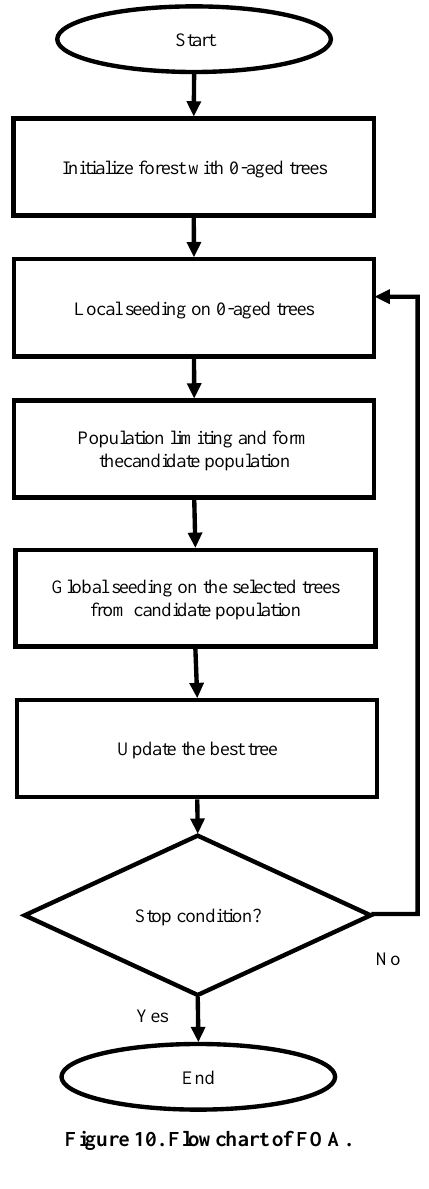
Figure 10. Flowchart of FOA.